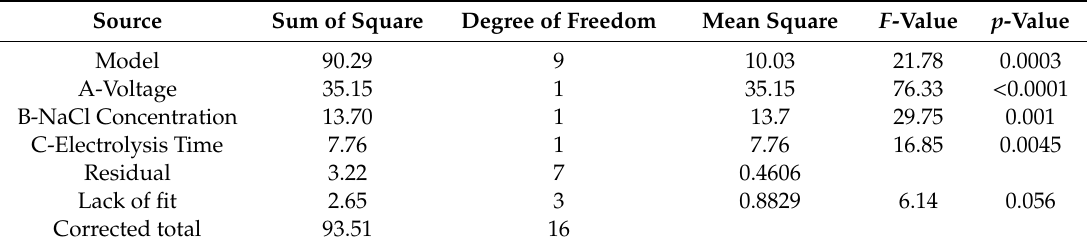
Table 10. Analysis of variance for the developed response surface quadratic model for chlorine content of AcEW.